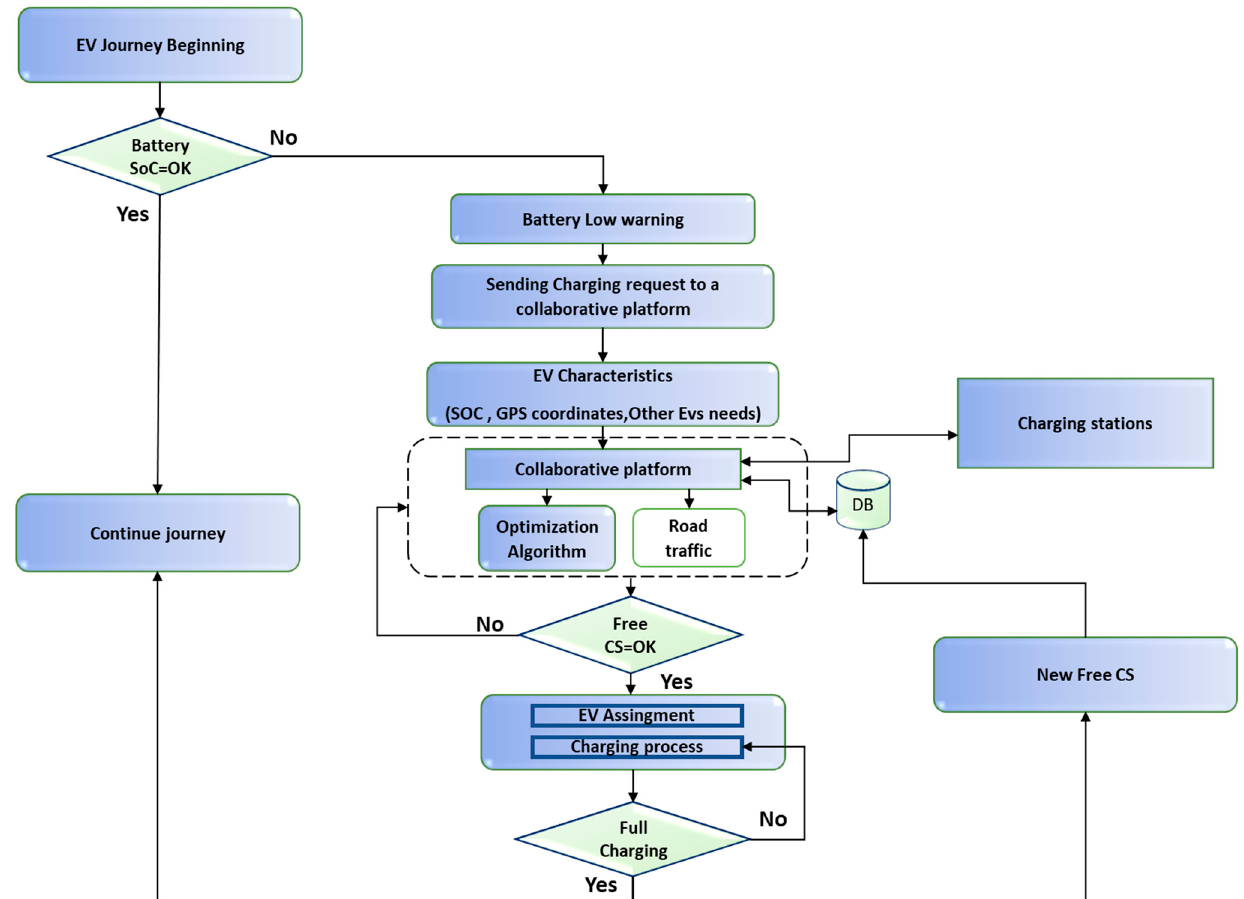
Figure 2. General framework of the proposed approach.